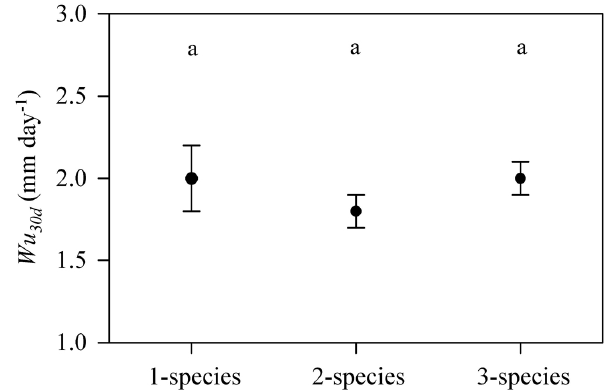
Figure 7. Wu 30d grouped for the three diversity levels during the soil desiccation period from 30 July to 1 September 2009. Values are means ± sd (1-species: n = 20; 2-, 3-species: n = 40); same letters specify no significant di ff erence between species (LME and Tukey’s